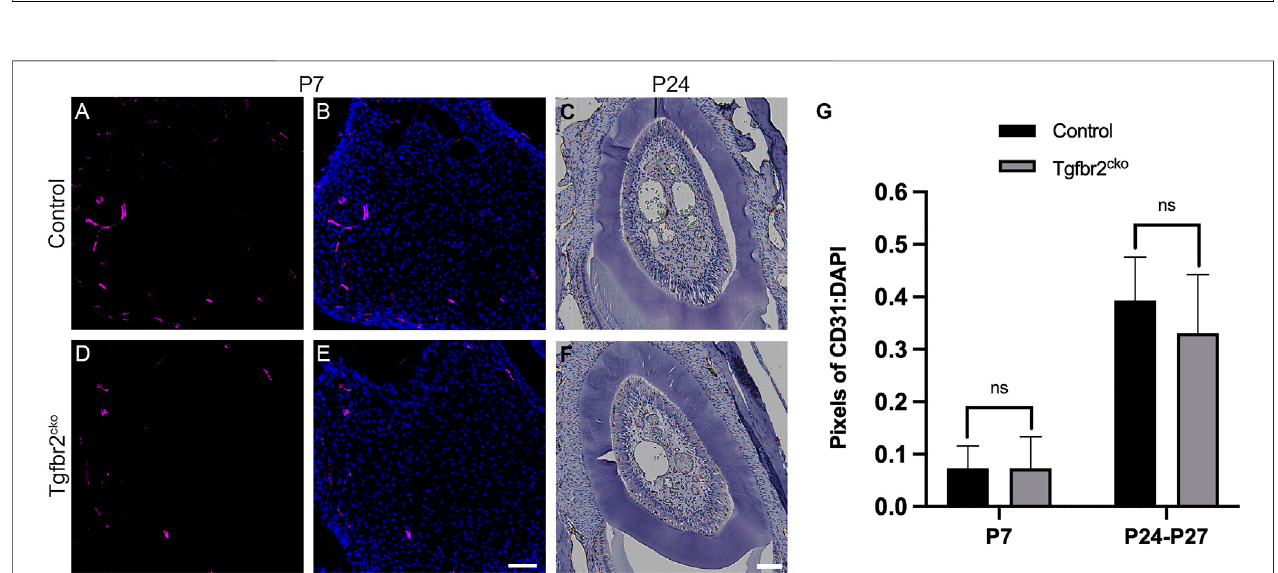
FIGURE 3 | Vascularization is not signi fi cantly different between Tgfbr2 cko and control Osterix-Cre P7 and P24-27 fi rst molars. Representative images of vascular structures labelled by CD31 in P7 and P24 control and Tgfbr2 cko M1s. (A,B,D,E) Representative confocal images of vasculature structures amidst DP cells (nuclei labelled by DAPI) in sagittal sections of P7 Osterix-Cre control (A,B) and Tgfbr2 cko (D,E) fi rst molars. (C – F) Representative bright fi eld images of CD31 IHC in horizontal sections of P24 control (C) and Tgfbr2 cko (F) fi rst molars. For quanti fi cation, confocal images (A,B,D,E) were thresholded using FIJI software to remove background fl uorescence and the remaining pixels were quanti fi ed and normalized to DAPI. For P24-P27 IHC images (C – F) , color deconvolution using FIJI preceded thresholding and quanti fi cation. For both time points, an unpaired t -test showed no signi fi cant difference between genotypes (G) . For P7, n = 3 for each genotype; for P24-P27, n = 5 for control and 6 for Tgfbr2 cko . The scale bars are 50 µm.